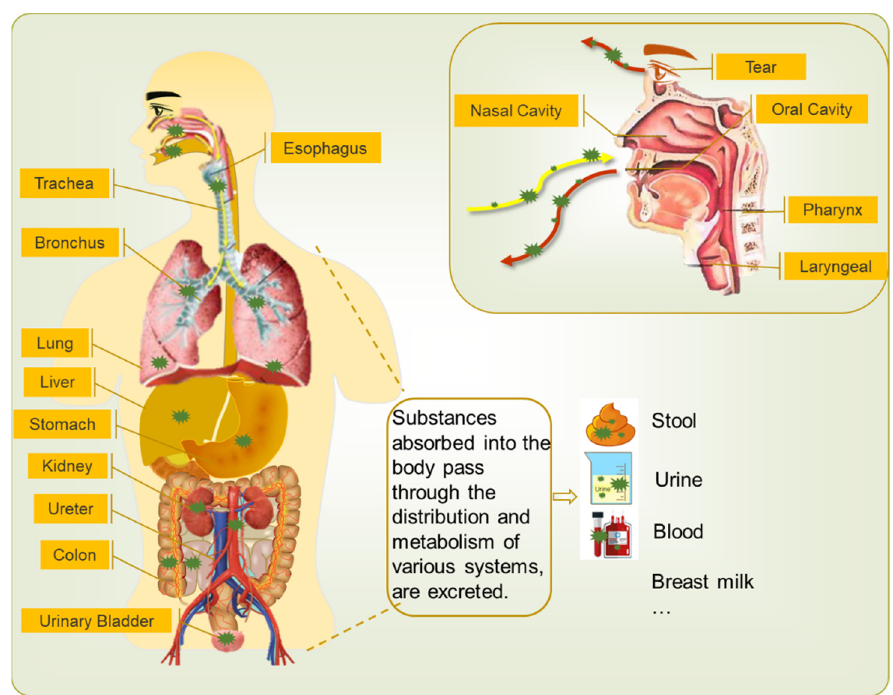
Figure 1. Schematic diagram showing the existence and secretion of virus in a human body. Coronavirus can enter our body through nose and mouth when we are eating, breathing, and so on. It can exist in the organs such as trachea, bronchus, lung, liver, stomach, kidney, and so on. The metabolites and excreta test positive for coronavirus, including tear, stool, urine, blood, breast milk, sputum, and droplets or aerosol from nose and mouth.